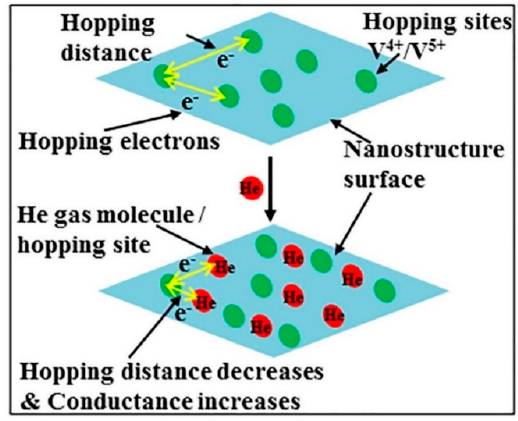
Figure 5. Sensing mechanism of hydrated V 2 O 5 gas sensor to He gas [55].